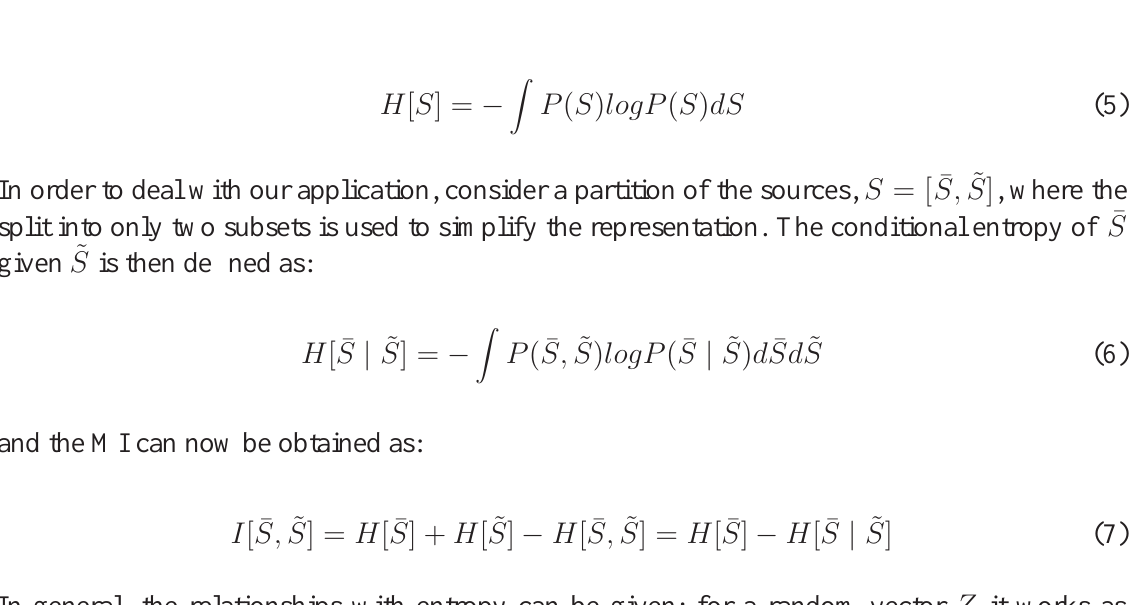
Figure 4: Scatter of three IC under system perturbation: IC 4 (top-left), ICz 4 (top-right), and corresponding plots for IC 5 and ICz 5